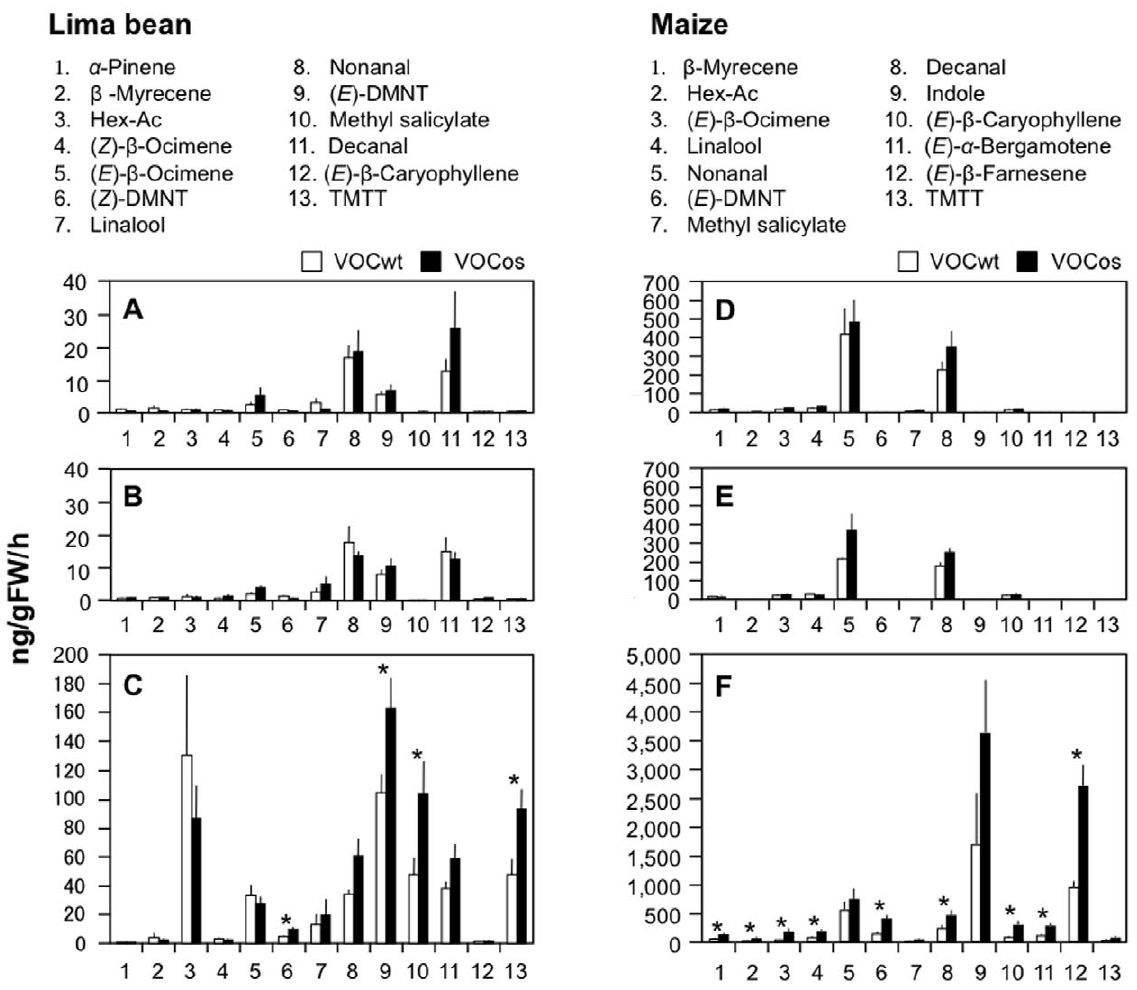
Figure 3. VOC emissions from receiver lima bean or maize plants in an open-flow tunnel. VOCs were collected from receiver lima bean or maize plants immediately after exposure to either VOCwt or VOCos ( A , D ), and after receiver plants were subjected to 1 day post-herbivory by T. urticae ( C ) or M. separata ( F ). Uninfested plants incubated for 1 day after VOC exposure served as controls ( B , E ). Data represent the mean + standard errors (n . 4). Asterisks indicate significant differences from control volatiles (Student’s t-test, P , 0.05).